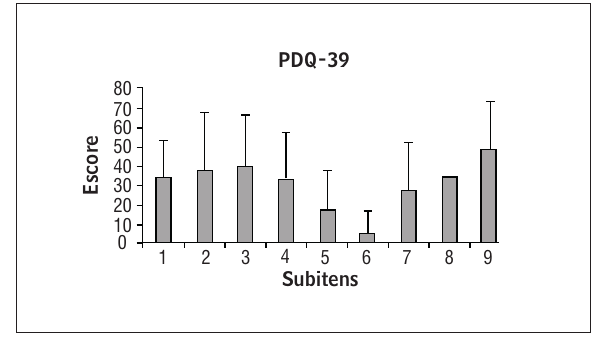
Figura 2 - Qualidade de vida de sujeitos GP –